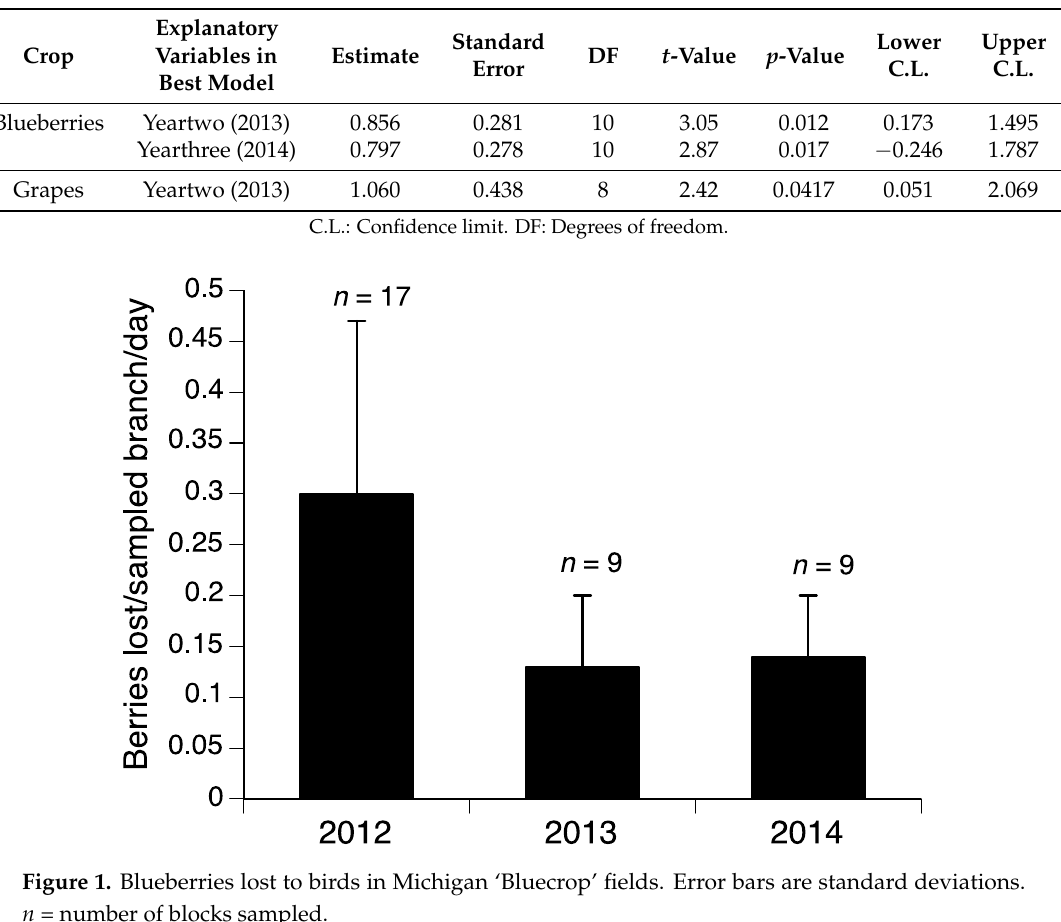
Table 2. Generalized linear model results for influences on bird damage for blueberries and grapes.